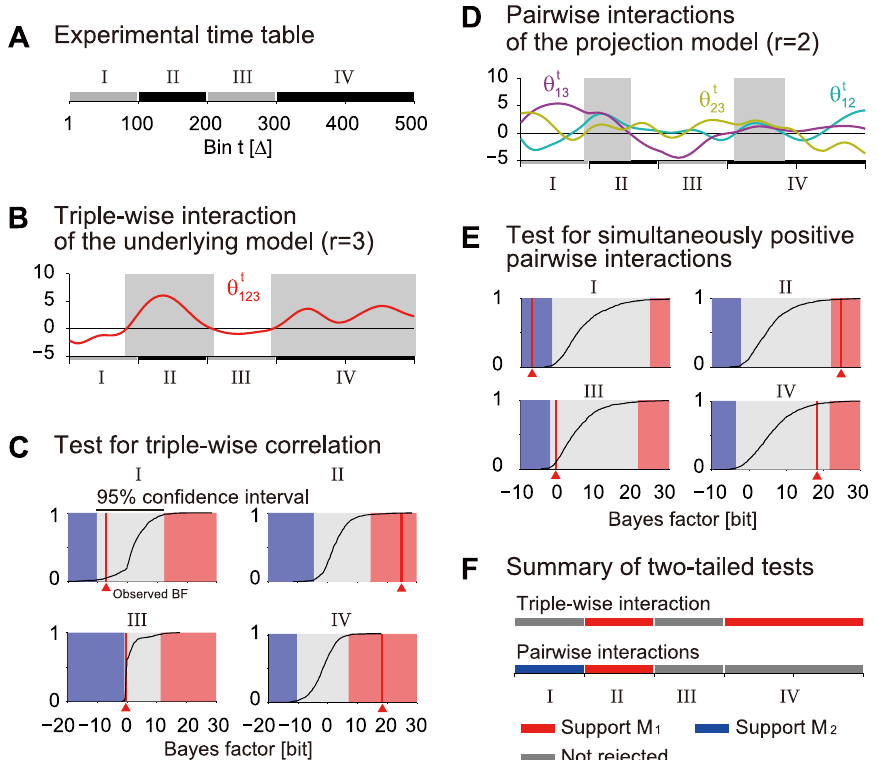
Figure 5. Detection of spike correlations and their relation to pseudo experimental protocol (simulation study). (A) Sketch of an assumed experimental time course composed of four epochs (I–IV), e.g., of different behavioral task conditions. Epochs I–III have a duration of ) 100 bins, period IV has a duration of 200 bins. (B) Time-varying triple-wise spike interaction parameter of the underlying model (cf. Figure 4C, h t 123 used for the simulation of spike data ( N ~ 3 neurons, n ~ 100 trials) during the time course outlined in A. The gray areas indicate the time intervals in w 0 . (C) Hypothesis testing for a triple-wise spike correlation based on surrogates. In each time period which the triple-wise interaction is positive: h t 123 (I–IV), we perform a test on the Bayes factor (BF) resulting from the original data. The observed BF (Eq. 12), marked by a red line and triangle, is t w 0 , as opposed to a zero or negative triple-wise interaction, M ƒ 0 . We then computed as evidence of a positive triple-wise interaction, M 1 : h t 2 : h 123 123 compare the ‘observed BF’ with cumulative distribution functions (CDFs, solid lines) for the BFs derived from surrogate data sets generated from a model containing only up to pairwise interactions ( r ~ 2 ). In all of the CDFs, the gray area indicates the 95% confidence interval of the distribution. If the observed BF falls into the lower tail of the distribution (blue area), M 2 is supported; if it falls into the upper tail (red marked area), M 1 is ( I [ V 2 ). These underlying supported. (D) Time courses of the underlying pair-interaction parameters of a pairwise log-linear model ( r ~ 2 ), h t I parameters are obtained by projecting the full underlying model ( r ~ 3 ) in Figure 4 to the pairwise model space, E 2 . The gray areas indicate the time periods in which all of the pairwise interactions are positive. (E) Similar tests as in C, but for the BF computed as evidence for the presence of t w 0 , as opposed to the absence of such an assembly, M ƒ 0 . (F) Compact simultaneous positive pairwise interactions, M 1 : V I [ V 2 , h t 2 : A I [ V 2 , h I I visualization of the test results from C and E. The colored bars show which hypotheses are supported in the different time segments (red and blue) and where the null hypothesis cannot be